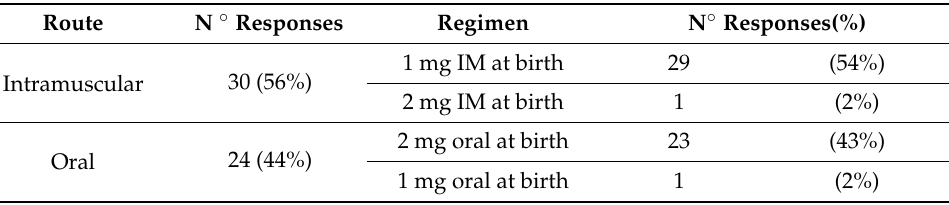
Table 4. Vitamin K prophylaxis for term formula-fed infants in Flanders (Reprinted with permission from ref. [49]. Copyright 2021 Belgian Society of